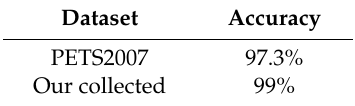
Table 1. The accuracy of target detection and tracking.